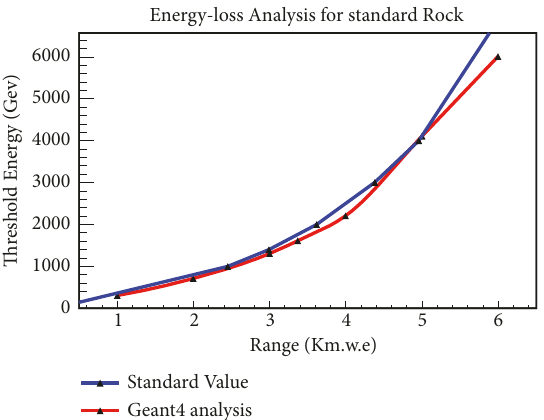
Figure 3: Muon energy loss versus range in standard rock, data (blue line data) dirctly taken from the PDG(Particle Data Group) web page[6] and the red line values are obtained from our simulation using Geant4, is shown for comparison. The threshold for the vertical muon hitting at the top surface at the INO location is 1.6